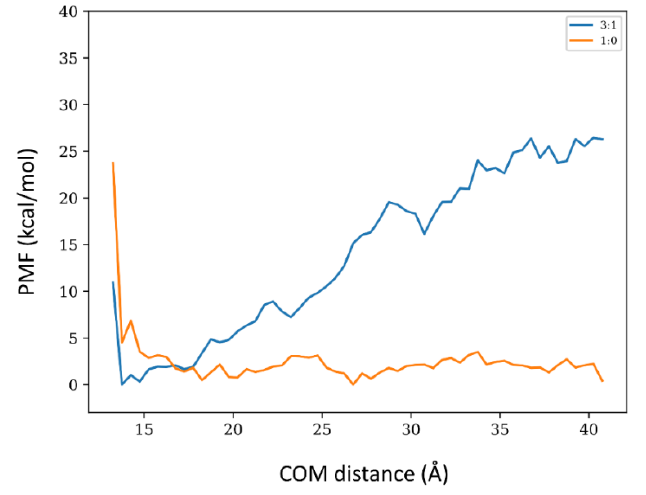
Figure 7. Exploratory Potential of Mean Force (PMF) of the axial transfer of SNX-482 bound to the membrane. To improve convergence, the toxin was orientationally, conformationally, and transla- tionally (x-y plane) restrained with respect to the bound configuration and sampled up to a 4.2 nm distance from the membrane upper leaflet. In blue and orange, the 3:1 and 1:0 systems. From the measured partition coefficient for other toxins, the free energy change of membrane binding is in the order of − 7 to − 8 Kcal/mol [12]. Our PMF calculations for the 3:1 system exhibit a (partial) binding free energy in the order of − 20